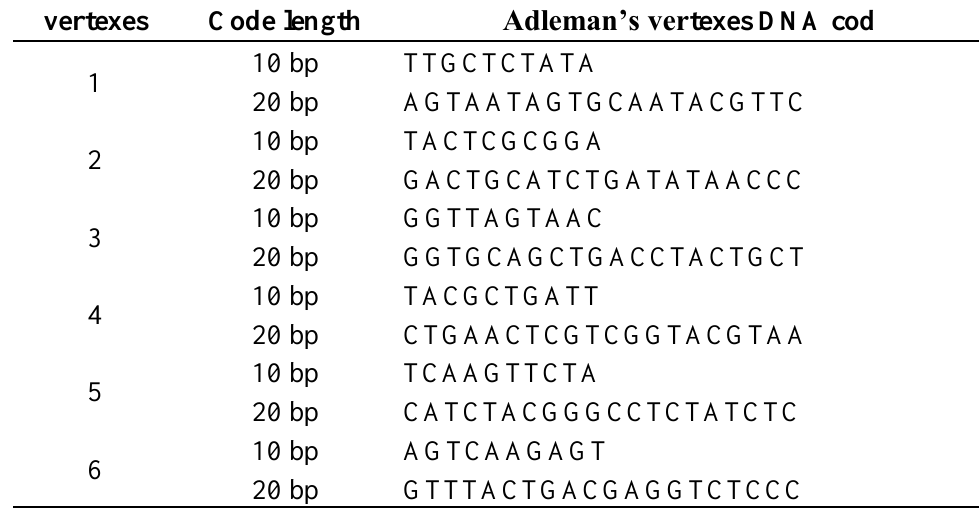
Table 6. DNA code for Adleman’3